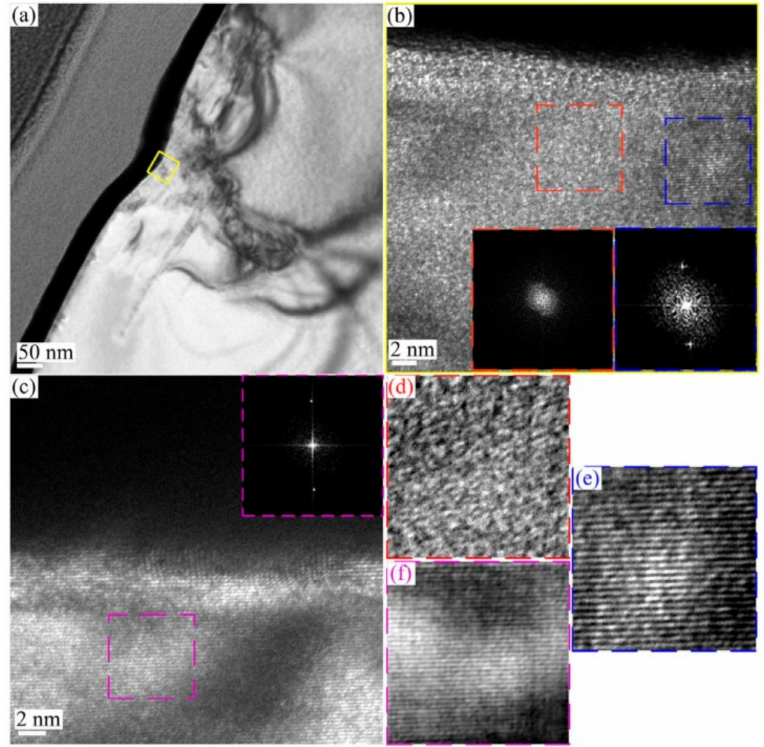
Figure 5. TEM image demonstrating amorphization underneath the indenter in SiC, ( a ) a bright field low-magnification TEM image of the plastically deformed 6H-SiC, ( b ) a high-magnification TEM image taken from the yellow border region of ( a ). ( c ) a high-magnification TEM image taken from region far away from the residual nanoindentation site. A reduced fast Fourier transformation (FFT) was conducted in the three selected regions marked by red, green and purple frames, as shown in the inserts; while the Wiener-filtered images of these regions are shown in ( d ), ( e ) and ( f ), respectively